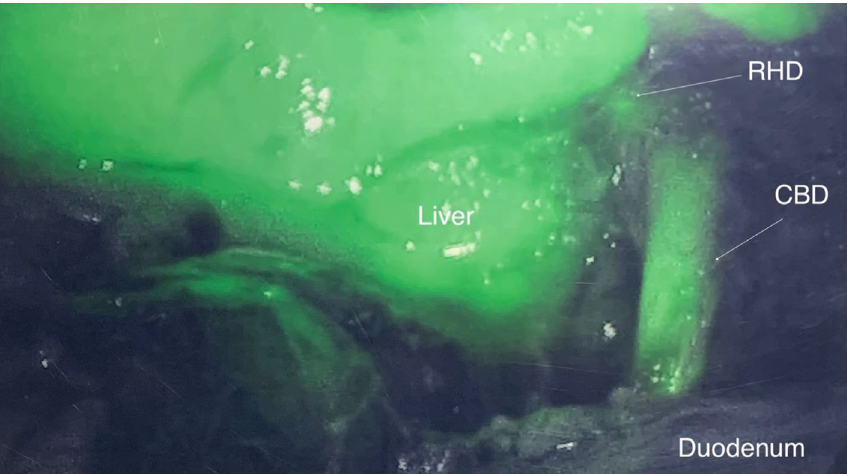
Figure 3: 35-Year-old female with biliary colic concerning for acute cholecystitis. Findings: intraoperative photograph showing the use of indocyanine green contrast viewing the common bile duct (CBD arrowed), the right hepatic duct (RHD arrowed), the liver, and the duodenum with the absence of a gallbladder.